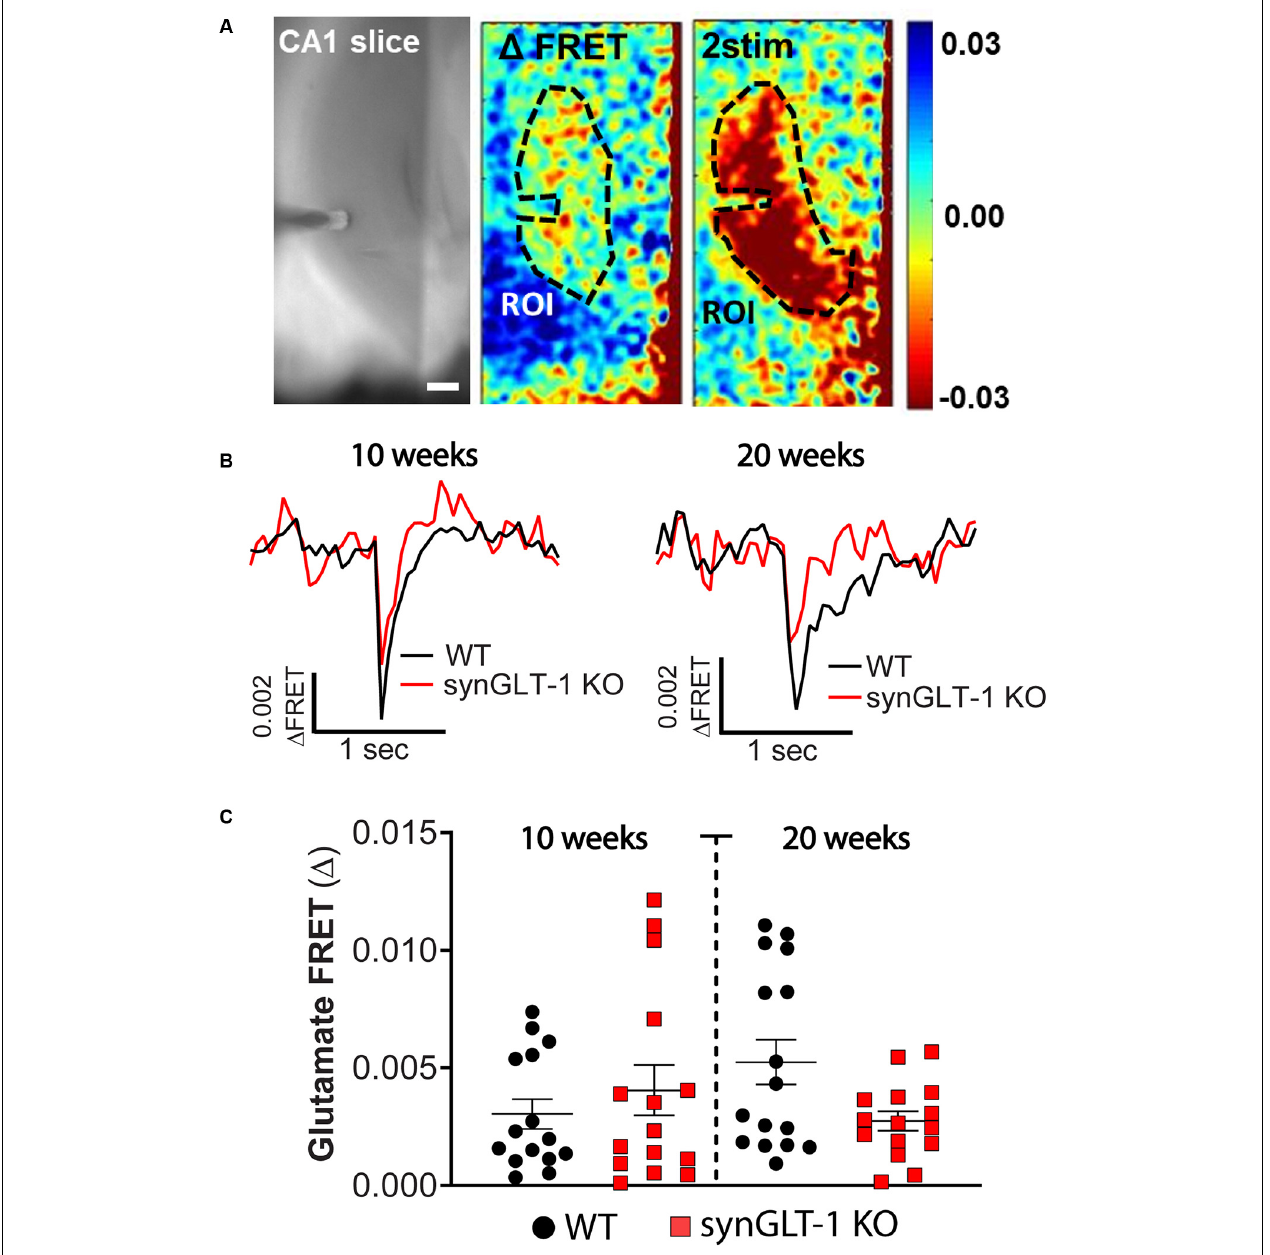
FIGURE 4 | Comparison of stimulus-evoked glutamate release in synGLT-1 KO and wild-type slices. Acute hippocampal slices were prepared from synGLT-1 KO and WT mice and loaded with a glutamate FRET sensor. A recording electrode was placed in the stratum radiatum of CA1 and a bipolar stimulating electrode was placed in the Schaeffer collateral/commissural fibers. (A) An example of images from a WT hippocampal slice. Left: phase contrast. Center: pseudo-colored glutamate response after one stimulus (center) and two stimuli at 20 Hz (right) and 0.3 mA intensity. The dashed line in the center and right images indicates the region of interest used in (B,C) . (B) Single trace of evoked extracellular glutamate FRET biosensor response in 10 weeks (left) and 20 weeks (right) old synGLT-1 KO (red) and WT littermate (black) mice. (C) Population of responses obtained at 10 (left) and 20 (right) weeks old synGLT-1 KO and WT mice. The responses in (B) and (C) were evoked by a single stimulus. There were no significant differences between responses in WT and synGLT-1 KO mice at 10 [Mann-Whitney U 106; p = 0.806 n = 15 (WT), 15 (KO)] or 20 weeks [(Mann-Whitney U 87; p = 0.202 n = 15 (WT), 16 (KO)]. Scale bar = 250 micrometers.